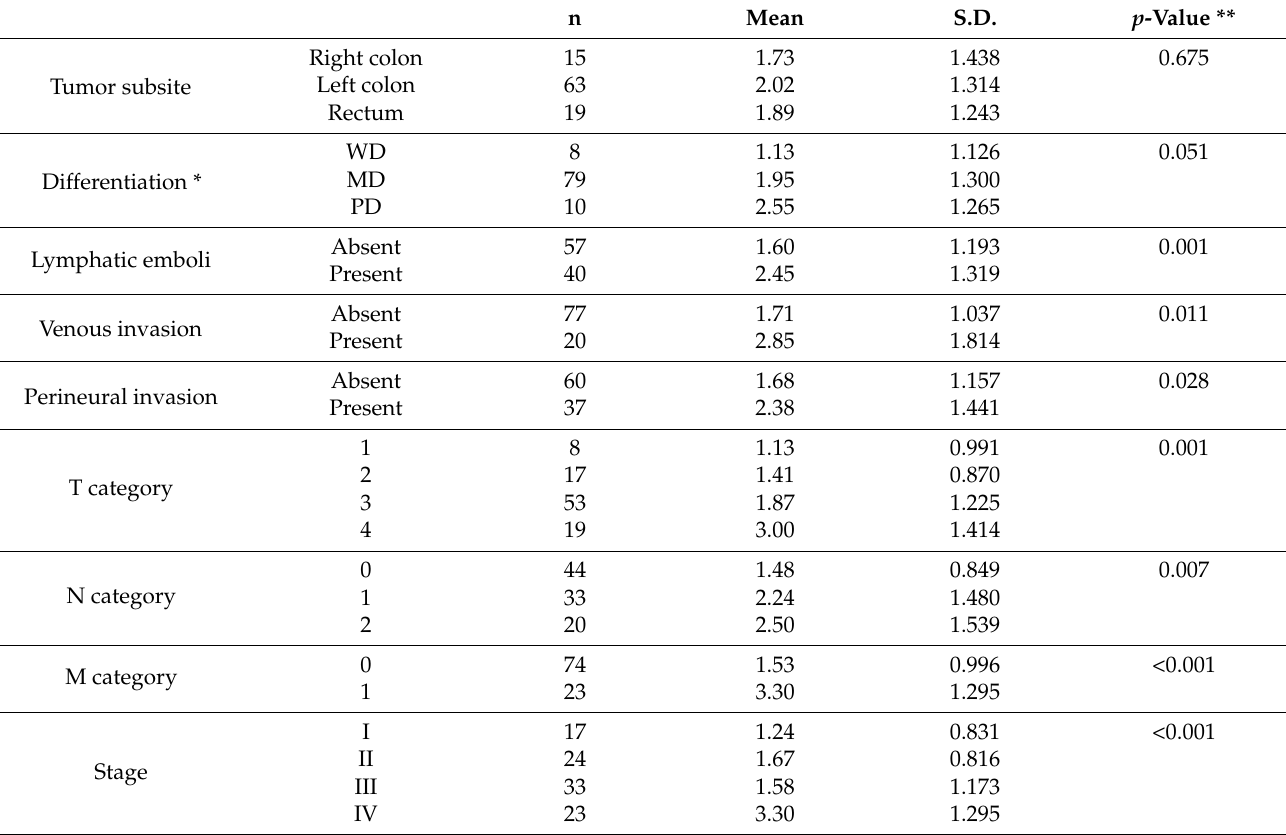
and specificity of 95.0% for tumor detection. The five-marker panel showed sensitivities of 35.3%, 54.2%, 45.5%, and 95.7% for stages I, II, III, and IV, respectively (Figure 2). The number of DNA methylation markers with ≥ 1 methylation-positive droplet(s) was signifi- cantly higher in CRCs with distant metastasis than in CRCs without distant metastasis, in CRCs with nodal metastasis than in CRCs with no nodal metastasis, in CRCs with a higher T category than in CRCs with lower T category, in CRCs with lymphatic emboli than in CRCs without lymphatic emboli, in CRCs with venous invasion than in CRCs without invasion (Table 3). Table 3. The number of methylated markers in cfDNA samples in relation to clinicopathological features of colorectal cancer patients ( n = 97). n Mean S.D. p -Value ** Right colon 15 1.73 Tumor subsite